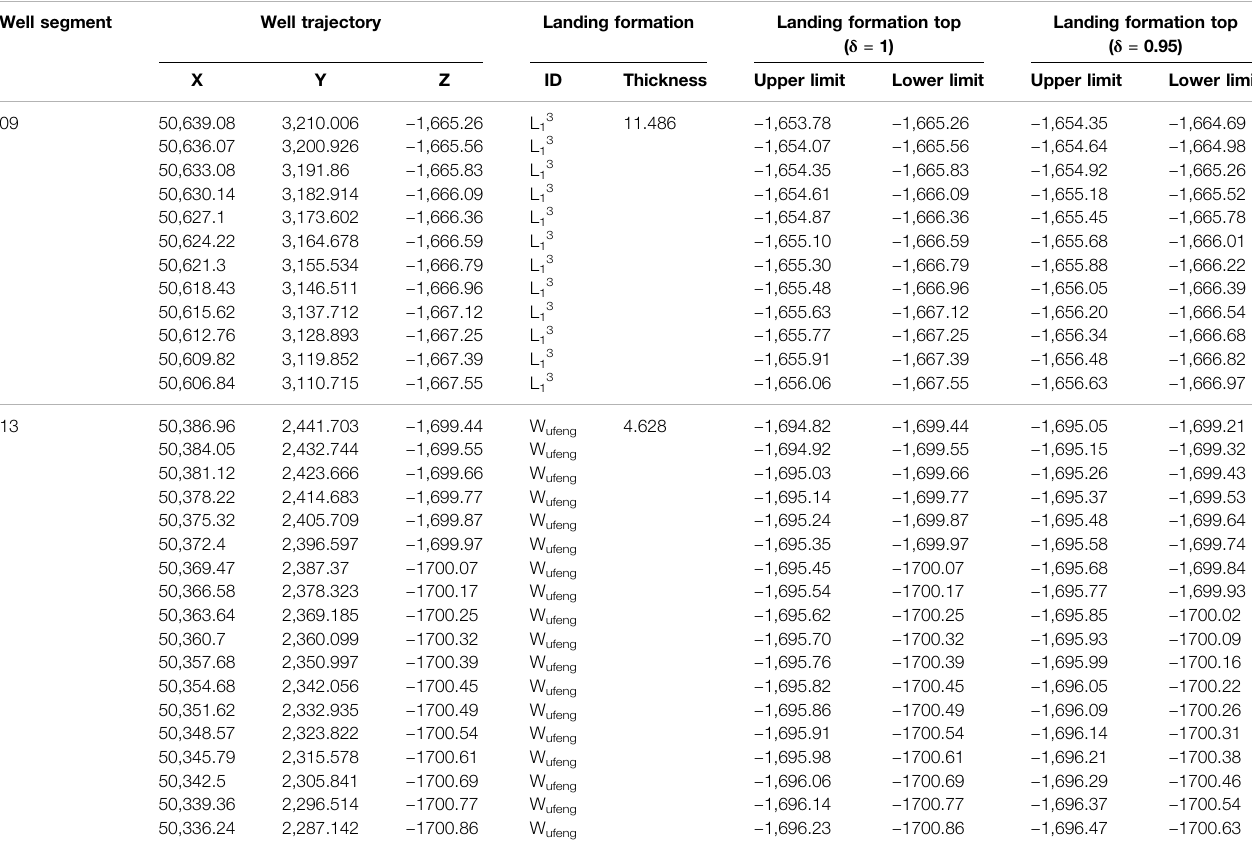
TABLE 1 | Example of Landing Formation Data and the Inferred Elevation Range of the Landing Formation Top. The data in gray- fi lled cells are for the added pseudo vertical wells. Well segment Well